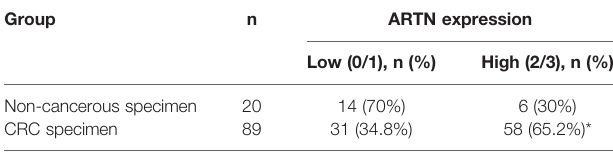
TABLE 1 | Expression of ARTN in colorectal tissues. Group